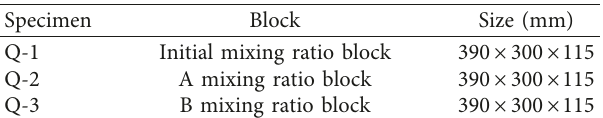
Figure 11: Testing machine in reality. Table 4: Specimen parameters.